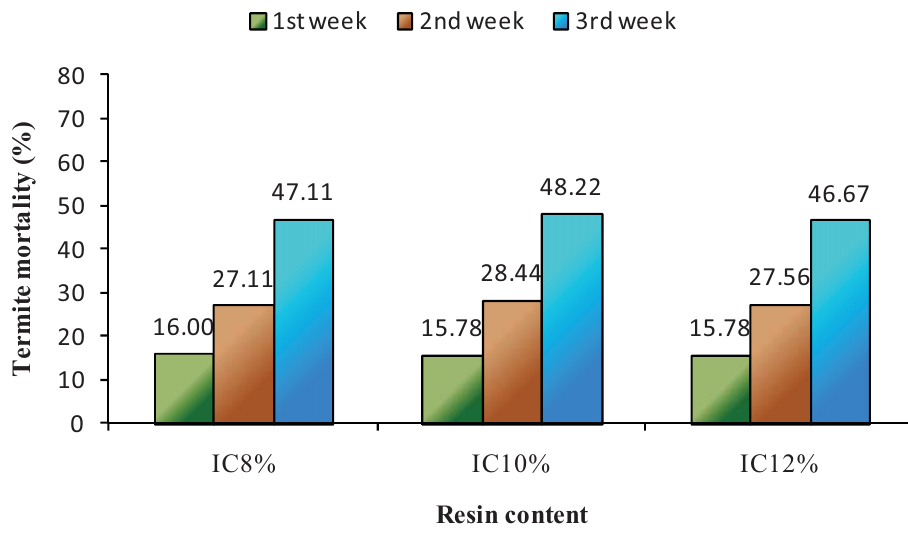
Figure 5. Weekly termite mortality on overlaid sisal